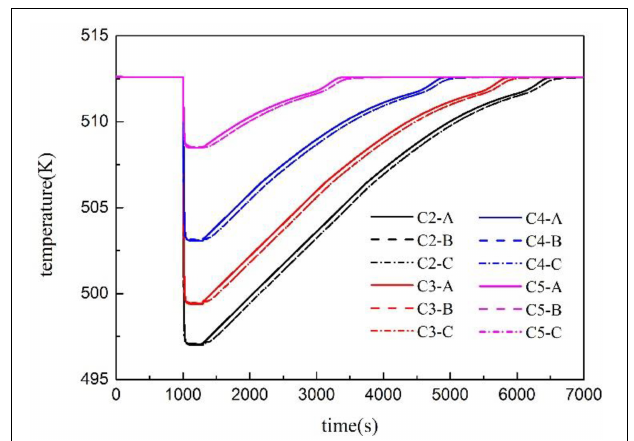
FIGURE 9 | Temperature of each pressure measuring point.